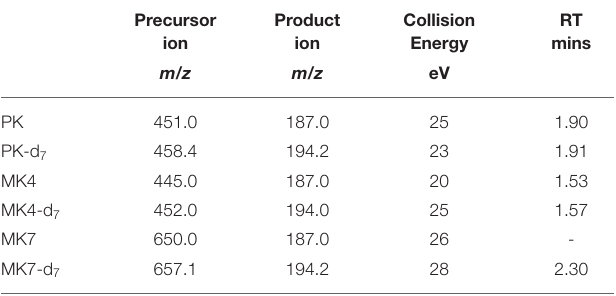
TABLE 1 | MRM transitions and RT for deuterated and non-deuterated phylloquinone (PK), menaquinone-4 (MK4), and menaquinone-7